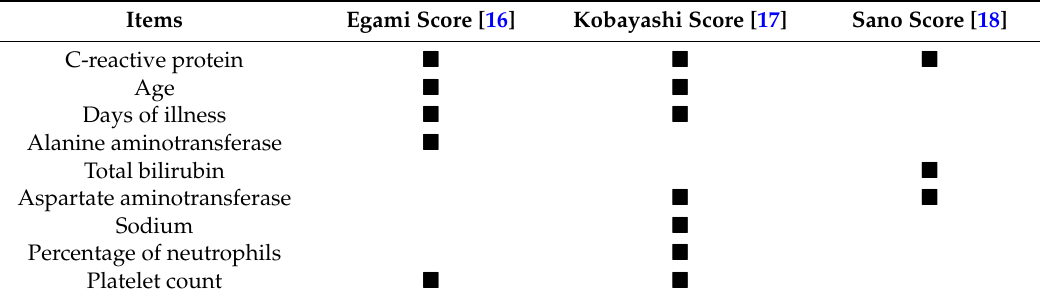
Table 2. Items evaluated in the different risk scores for Kawasaki